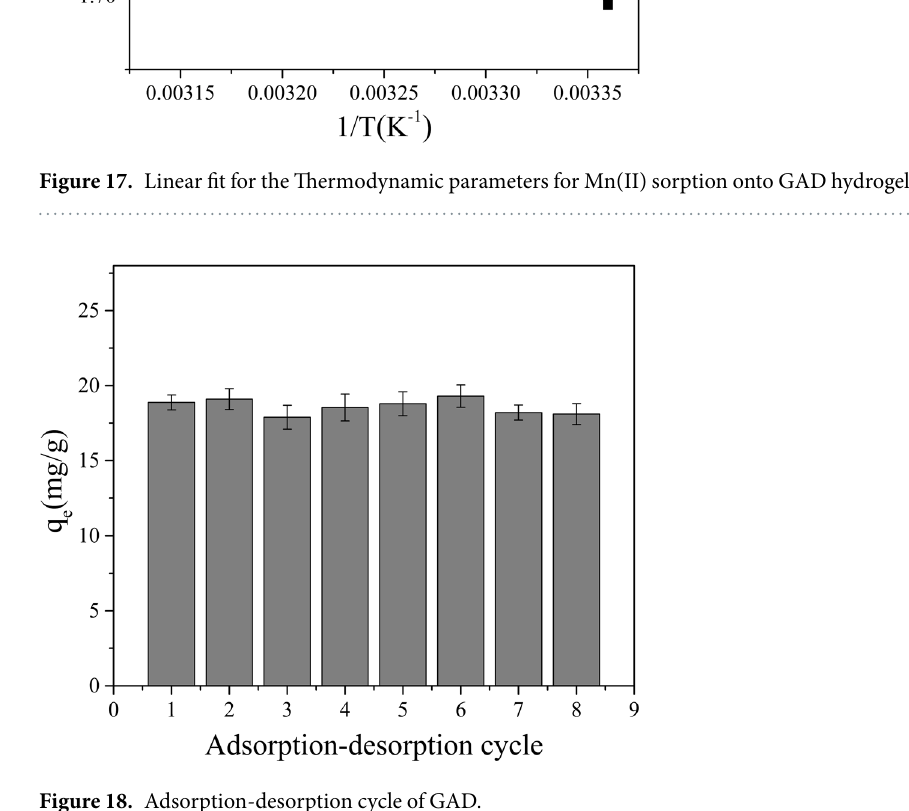
Figure 18. Adsorption-desorption cycle of